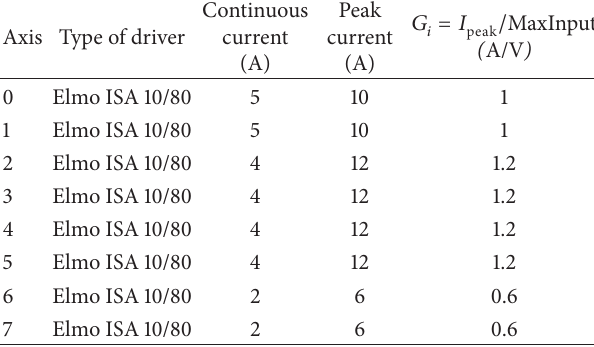
Table 3: Drivers.